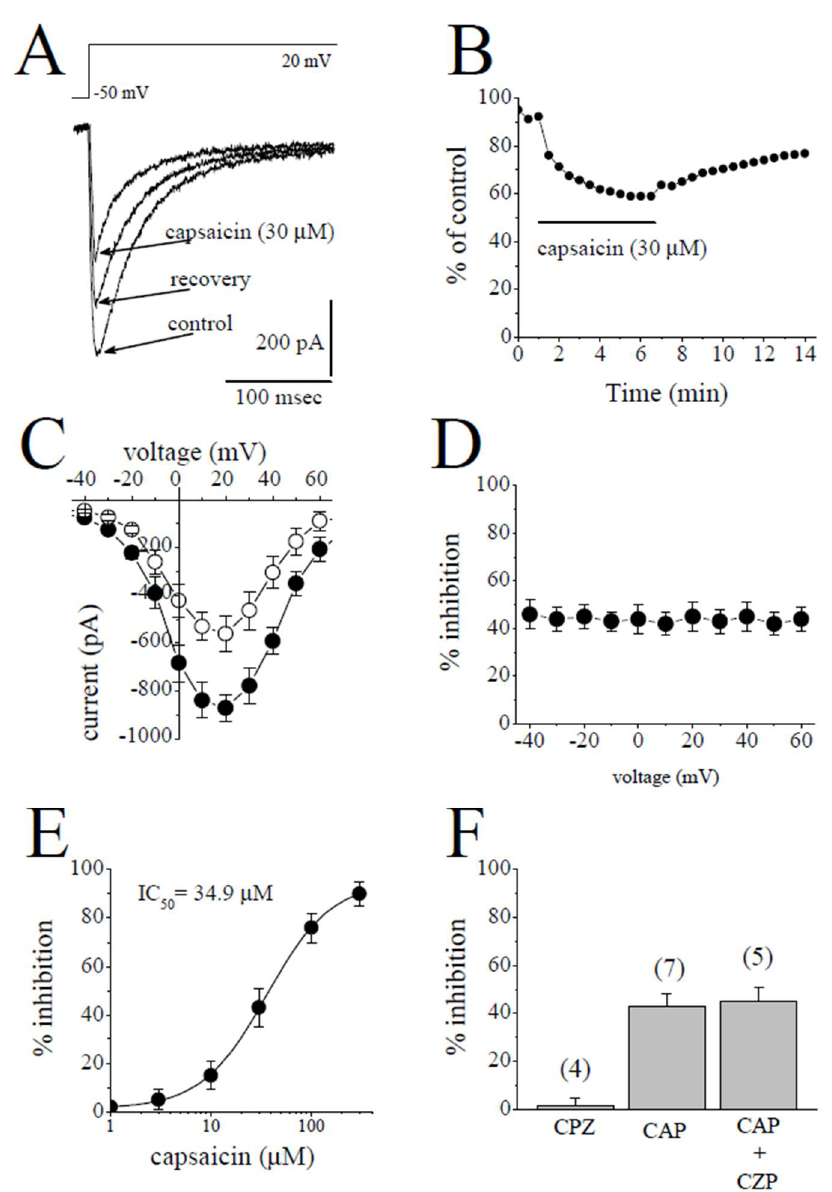
Figure 2. Capsaicin suppresses the I L-Ca in rabbit ventricular myocytes. ( A ) Superimposed current traces in control, after 5 min exposure to 30 µ M capsaicin and recovery. The pulse protocol to evoke I L-Ca is shown as an inset. ( B ) Time course of the effect of capsaicin on the maximal amplitudes of I L-Ca presented as % of control calculated from the mean of three control currents. ( C ) Current–voltage curves of I L-Ca in the absence and presence of 30 µ M capsaicin are presented with filled and open circles, respectively ( n = 5). ( D ) The relationship between test potential and the capsaicin (30 µ M) inhibition of I L-Ca ( n = 5; p > 0.05, ANOVA). ( E ) Concentration-inhibition relationship for capsaicin suppression of I L-Ca ( n = 3–6). ( F ) The effect of capsazepine (3 µ M) and the extent of capsaicin (30 µ M) inhibition of I L-Ca in the absence and presence of 3 µ M capsazepine. The number of cells tested for each group was presented on top of each bar ( p > 0.05; t